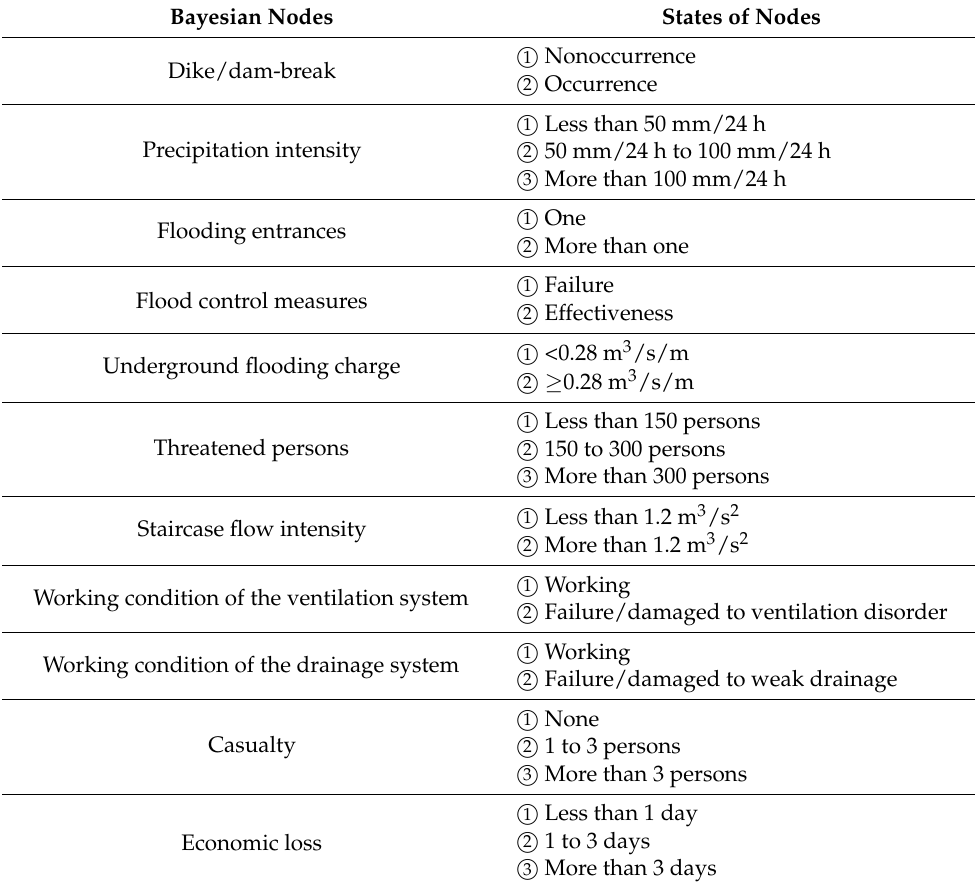
Table 2. Classified states of Bayesian network (BN)